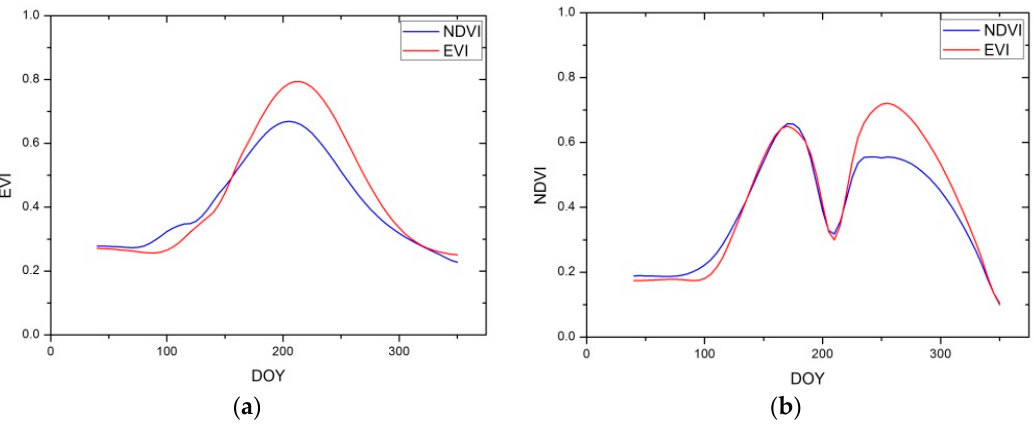
Figure 4. Typical patterns of the time profiles for filtered NDVI and EVI. ( a ) EVI and NDVI time profiles of single season rice; ( b ) EVI and NDVI time profiles of double season rice. of single season rice; ( b ) EVI and NDVI time profiles of double season